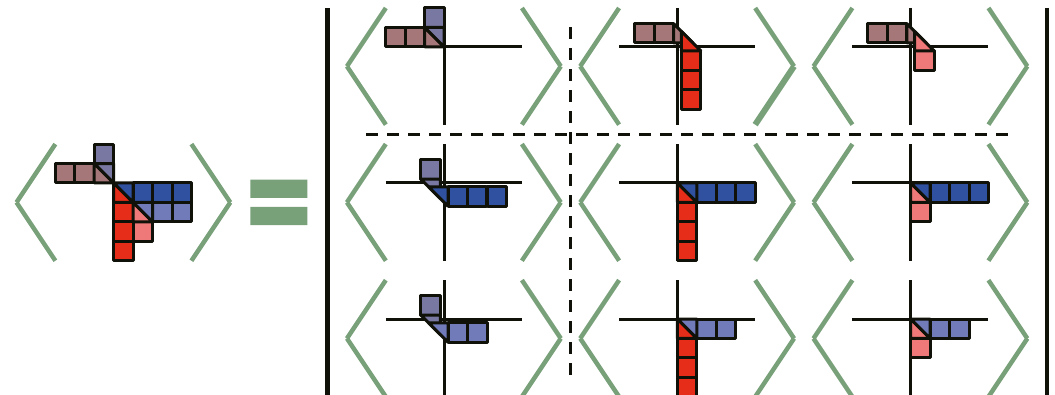
Figure 7 . Giambelli formula for the two-point functions in the ABJM matrix